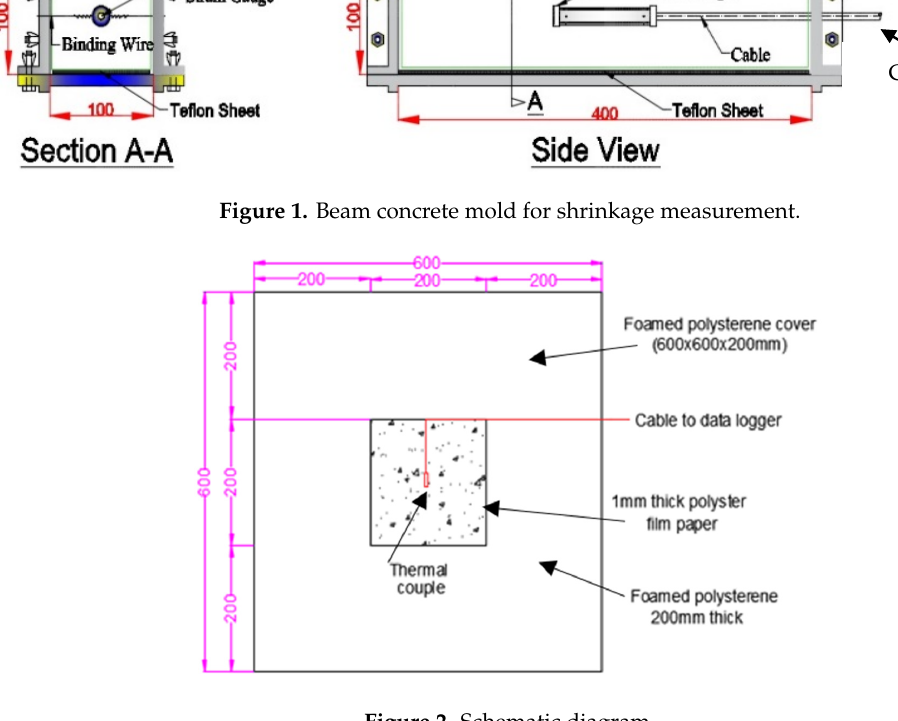
Figure 2. Schematic diagram. Figure 2. Schematic